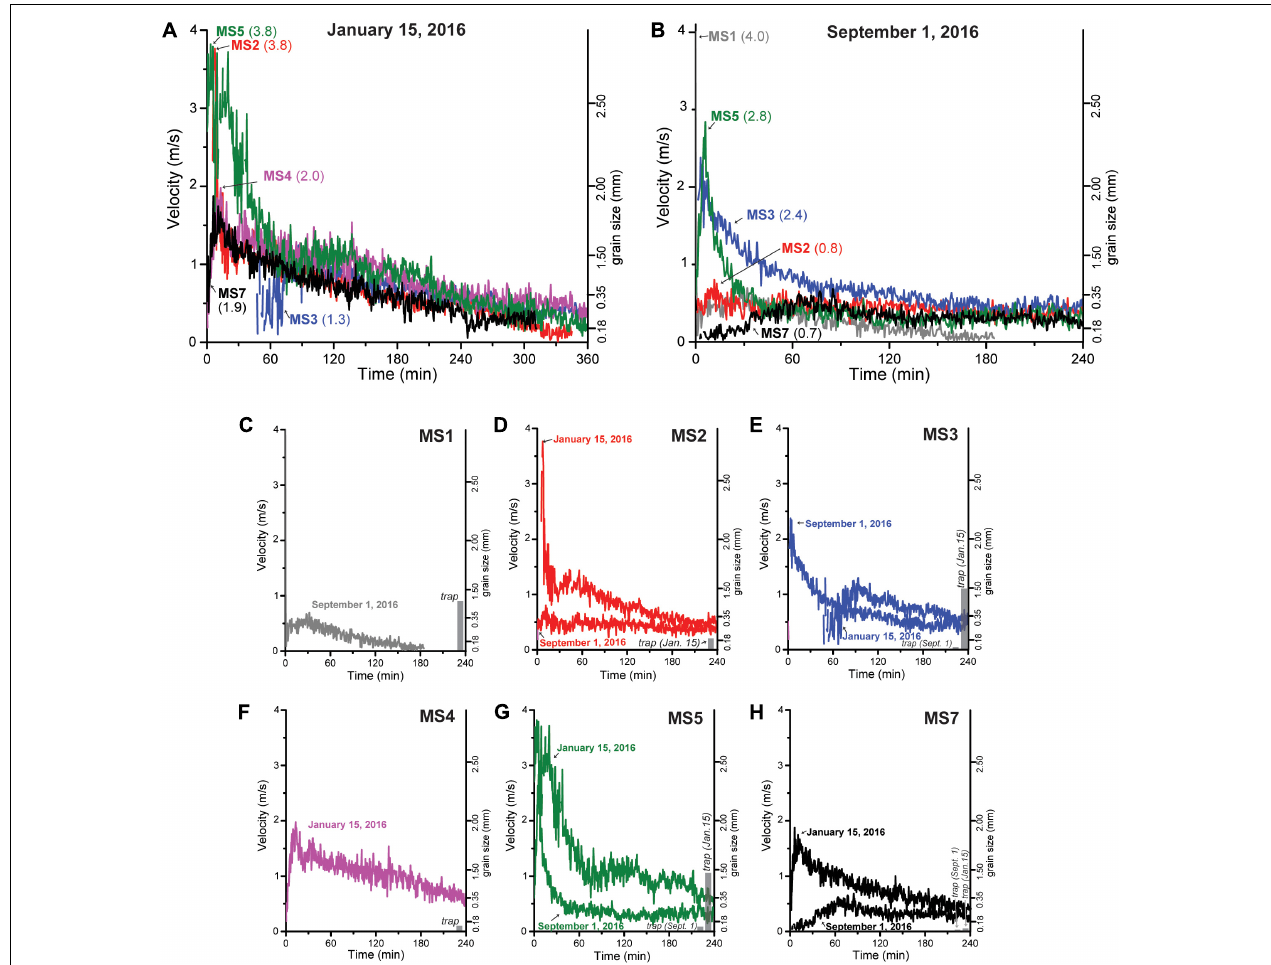
FIGURE 6 | Acoustic Doppler current profiler (ADCP)-measured velocity from approximately 10 m above the seafloor (masf; ADCP bin 055) adjacent to sediment trap samples at 10 masf. Grain size axes calculated after Komar (1985) and Ferguson and Church (2004). Velocity profiles in (A) from the January 15, 2016 event and (B) from the September 1, 2016 event, are labeled with mooring (MS#) and maximum ADCP-measured velocity (m/s) in each event at ∼ 10 masf. Plots (C–H) show ADCP-measured velocities from each mooring and the range of measured d0.1 to d0.9 grain sizes in sediment traps from ∼ 10